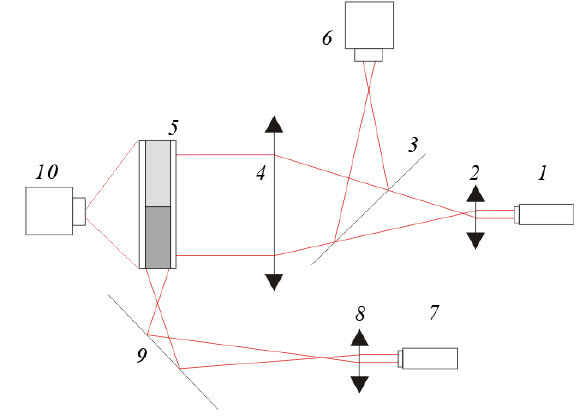
Fig. 1. Sketch of the experimental setup